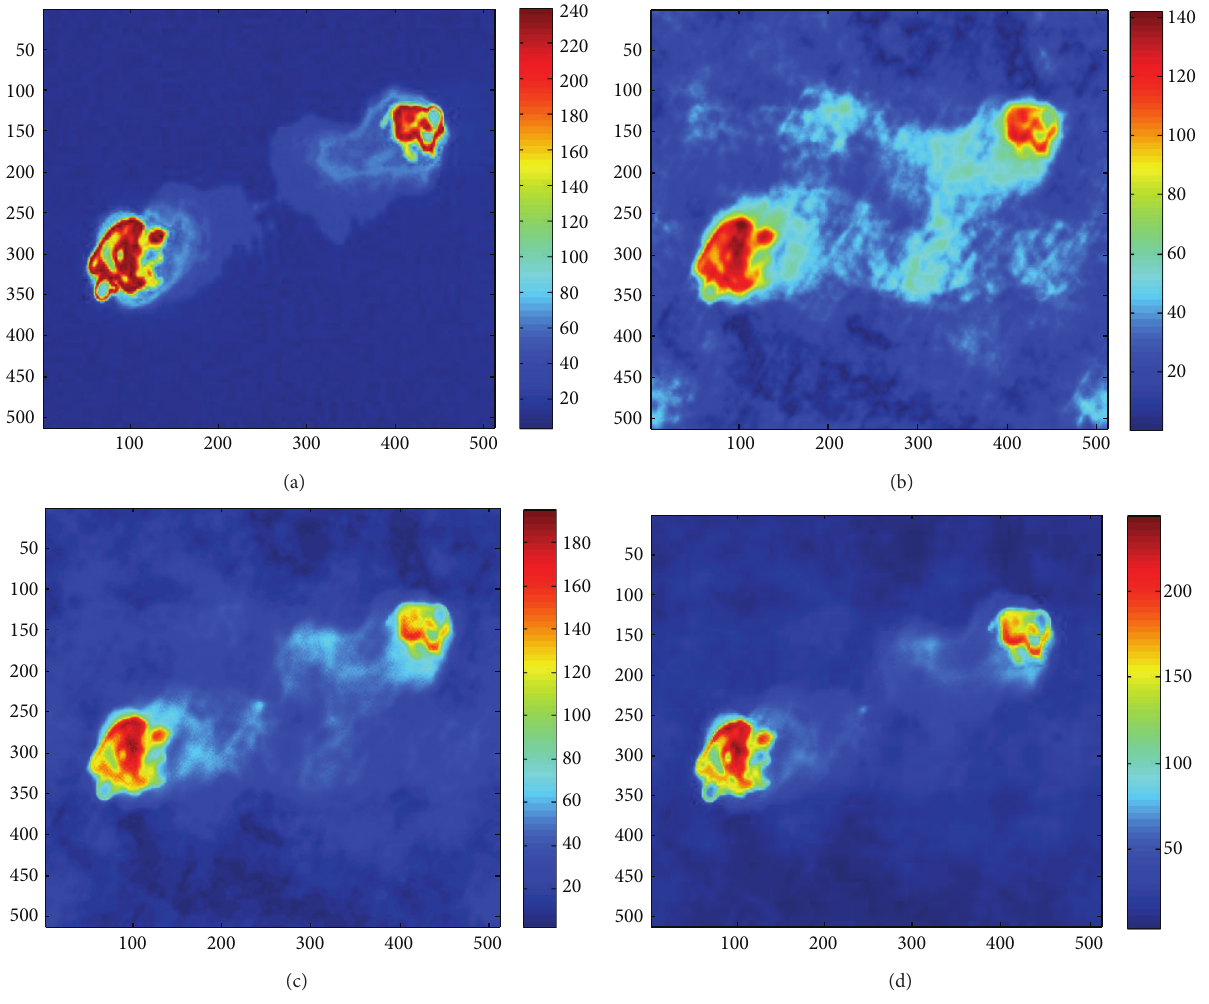
Figure 5: (a) The image of Cygnus A. (b) Reconstructed image using CSC algorithm (RelErr = 75.2%, SNR = 18.2). (c) Reconstructed image using CS algorithm (RelErr = 23.5%, SNR = 10.2). (d) Reconstructed image using our method (RelErr = 15.7%, SNR =